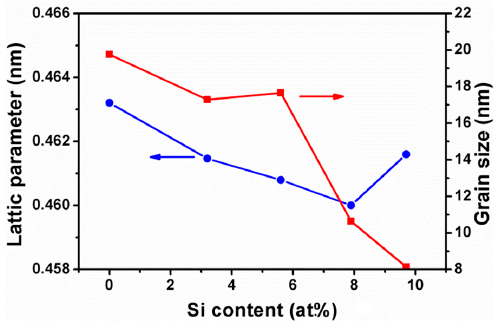
Figure 8. Lattice parameters and grain sizes of the Zr–Si–N films.